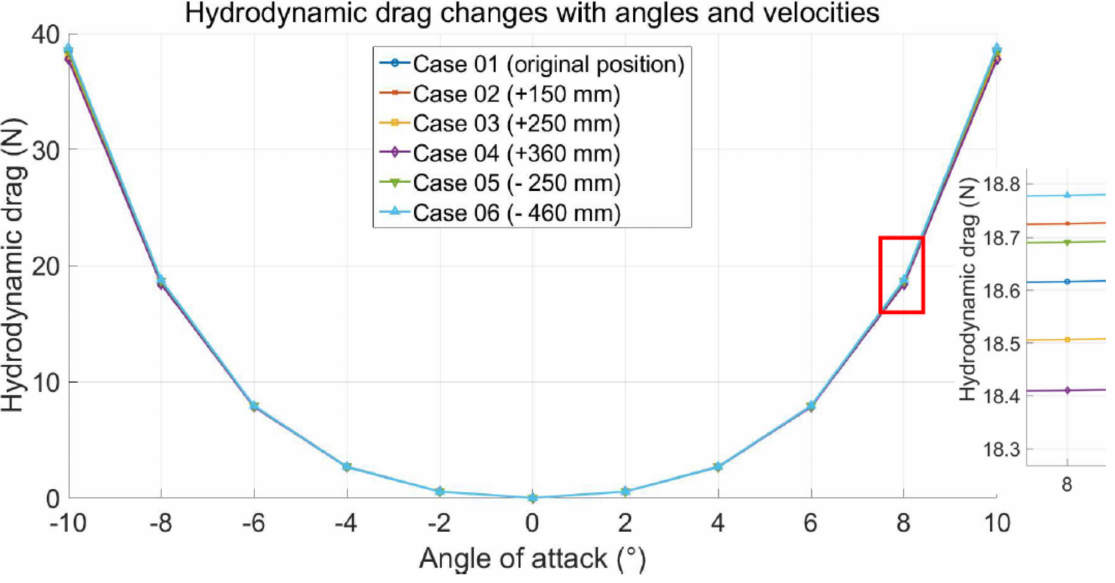
Figure 8. Variation in the hydrodynamic drag according to angles and